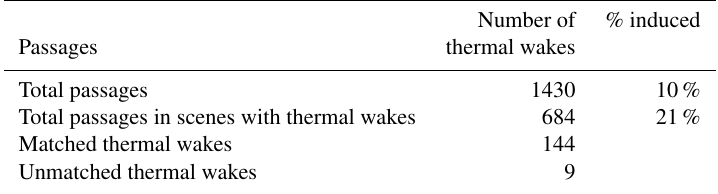
Table 3. Number of ship passages in the analysed satellite scenes and the percentage of passages inducing thermal wakes. Number of % induced Passages thermal wakes Total passages 1430 10% Total passages in scenes with thermal wakes 684 21% Matched thermal wakes 144 Unmatched thermal wakes